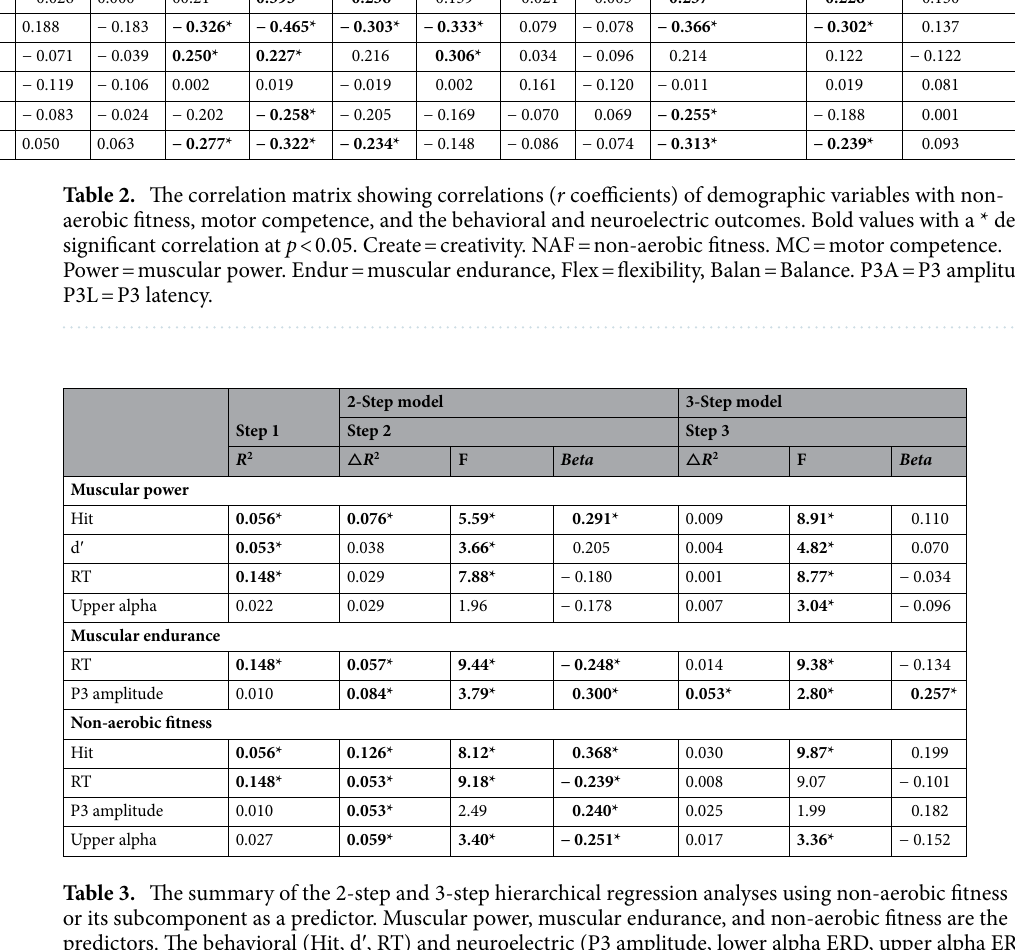
creased upper alpha (i.e., greater ERD). After further controlling for MC in the 3-step models, only a positive association between muscular endurance with P3 amplitude was observed (see Fig. 1D). Motor competence. After controlling for age in the first step, ball skills were unrelated to any neurocognitive variable in the 2-step models, while MC and its coordination and dexterity component showed beneficial asso- ciations with behavioral outcomes and upper alpha ERD (see Table 4). All these associations remained after further controlling the NAF in the 3-step models, except that upper alpha ERD was no longer predicted by MC (see Fig. 1D).